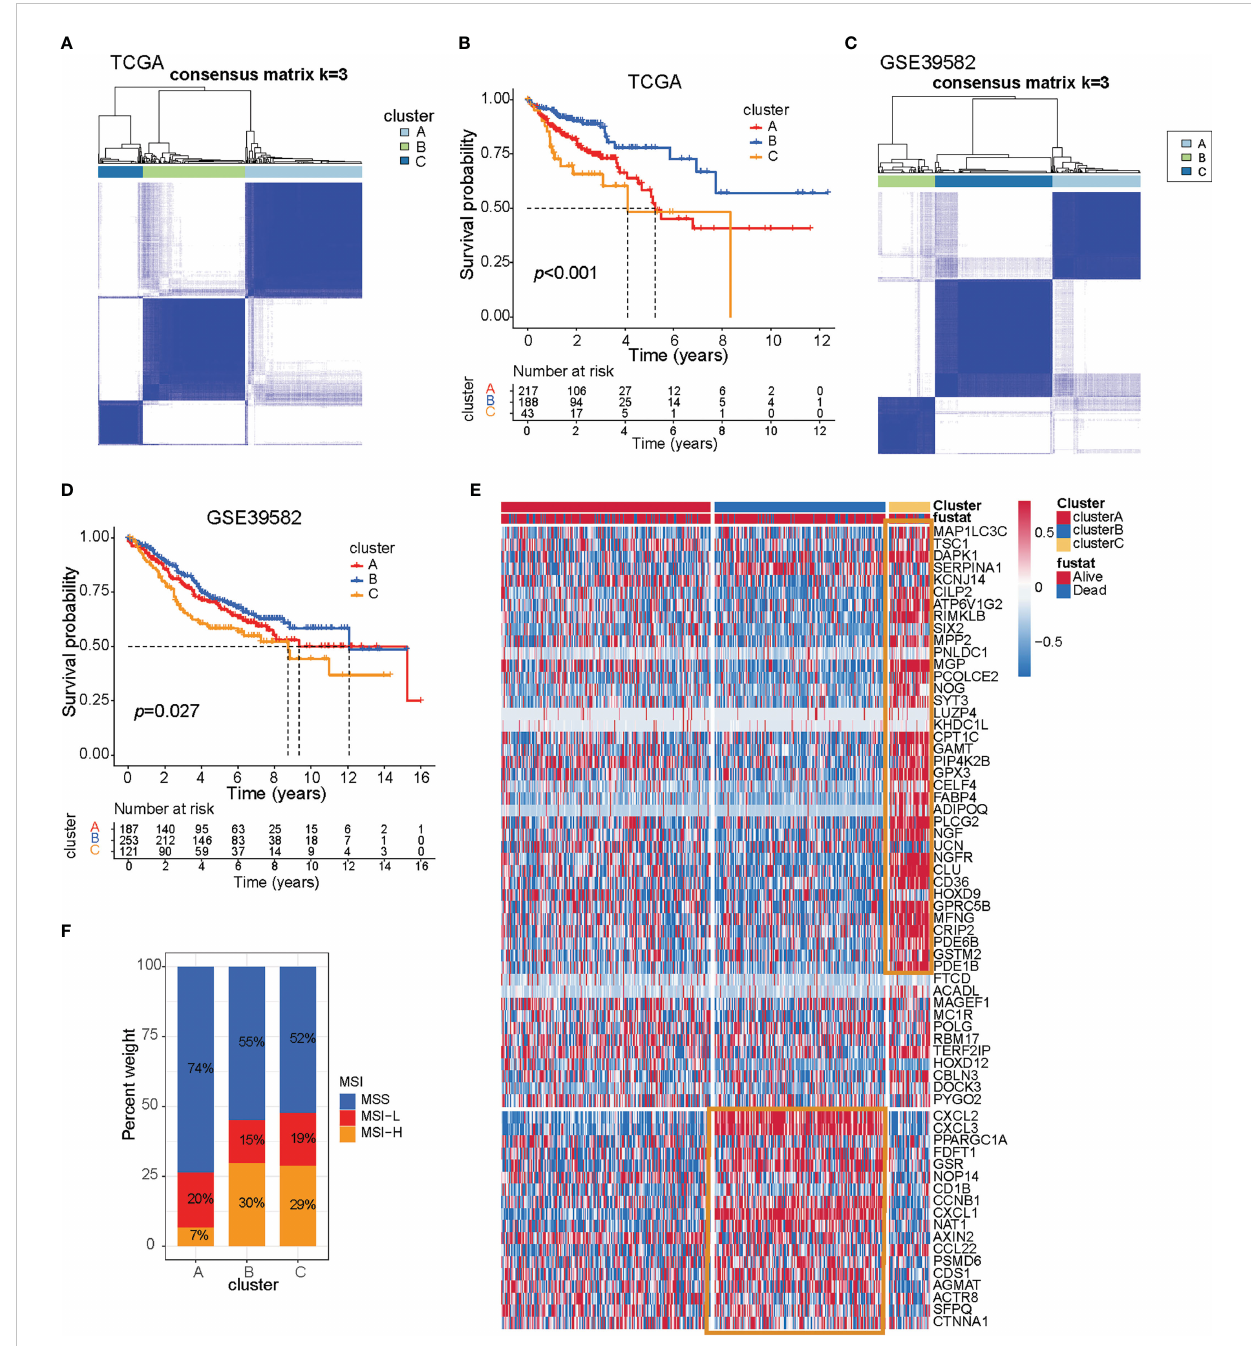
FIGURE 1 Three prognostic molecular subtypes of colon cancer. (A) Clustering heat map based on 66 prognosis-related genes in TCGA-COAD cohort. (B) Survival curve of TCGA-COAD patients in different clusters. Survival differences were assessed with a log-rank test. (C) Clustering heat map based on 66 prognosis-related genes in the GSE39582 cohort. (D) Survival curve of GSE39582 patients in different clusters. Survival differences were assessed with a log-rank test. (E) Heat map of 66 prognosis-related genes in TCGA-COAD cohort. (F) The proportion of microsatellite instable subtypes in A – C subtypes of TCGA-COAD